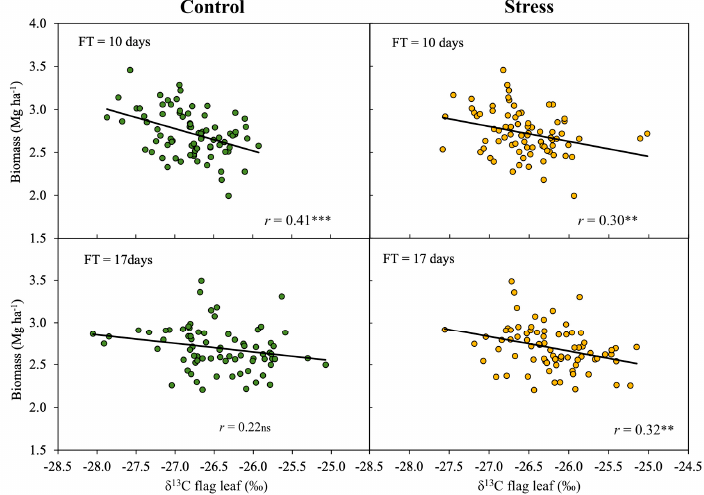
Figure 5. Linear regression of the relationship between the plant biomass at mid grain filling and the stable carbon isotope composition ( δ 13 C) in the flag leaf dry matter sampled before stress conditions were imposed ( δ 13 C control, right panels) and two weeks after the last irrigation ( δ 13 C stress, left panels) across the subset of genotypes exhibiting the same date of anthesis: 10 days after the earliest genotype (n = 76) and 17 days (n = 63). Level of significance, ns p > 0.05, ** p < 0.01, *** p < 0.001.